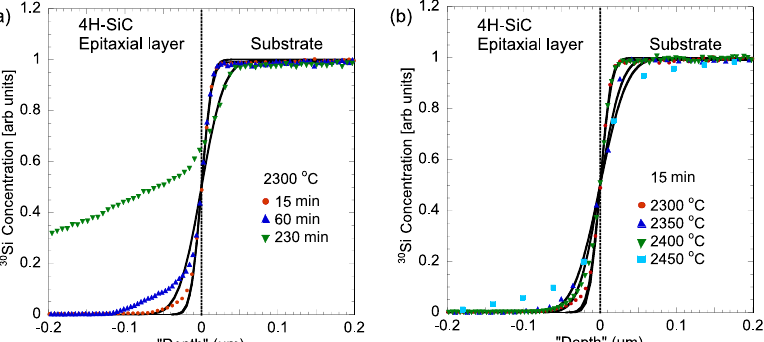
Figure 3. 30 Si profiles as detected by SIMS and fitted according to Equation (1), at ( a ) 2300 ◦ C for 15, 60, and 230 min annealing, and ( b ) for annealing at various temperatures between 2300–2450 ◦ C for 15 min. The profiles were collected at the interface between the isotope purified epi-layer and the 4H-SiC substrate, at approximately 7 µ m from the epi-layer